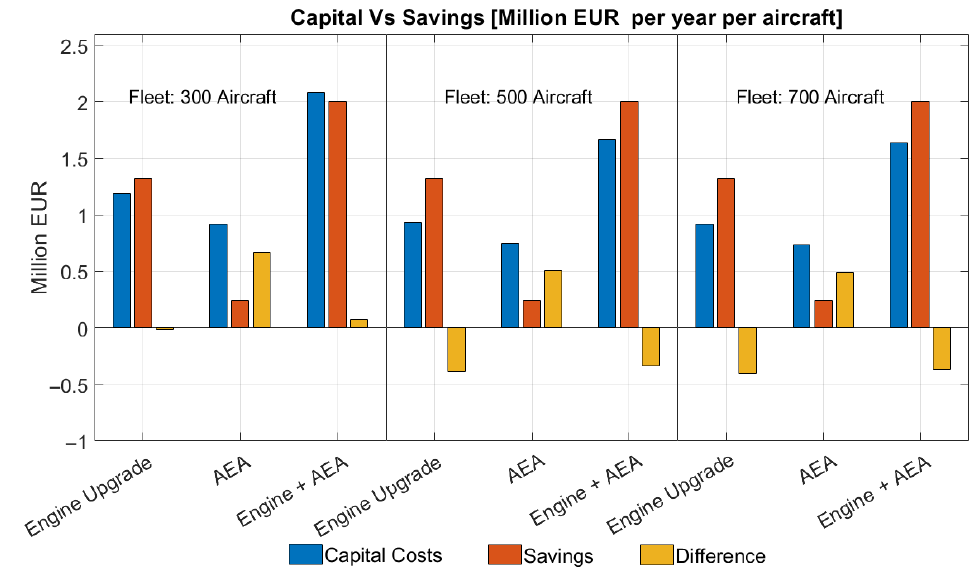
Figure 12. Capital costs and savings and their difference per year per aircraft. The fuel price considered is EUR 108 per barrel, +36%, as taken from Error! Reference source not found. .